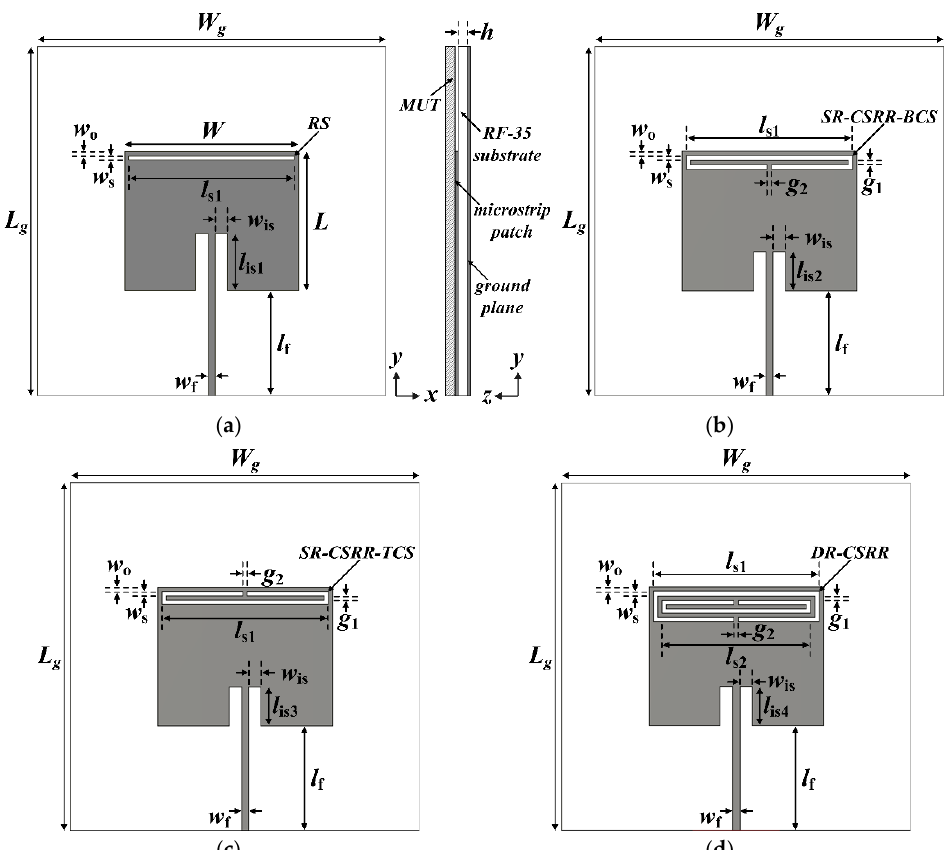
Figure 1. Geometries of the rectangular MPAs loaded with ( a ) a rectangular slot (RS), ( b ) a single ‐ ring complementary split ring resonator with a bottom ‐ edge center split (SR ‐ CSRR BCS) slot, ( c ) an SR ‐ CSRR with a top ‐ edge center split (SR ‐ CSRR TCS) slot, and ( d ) a double ‐ ring CSRR (DR ‐ CSRR) slot.